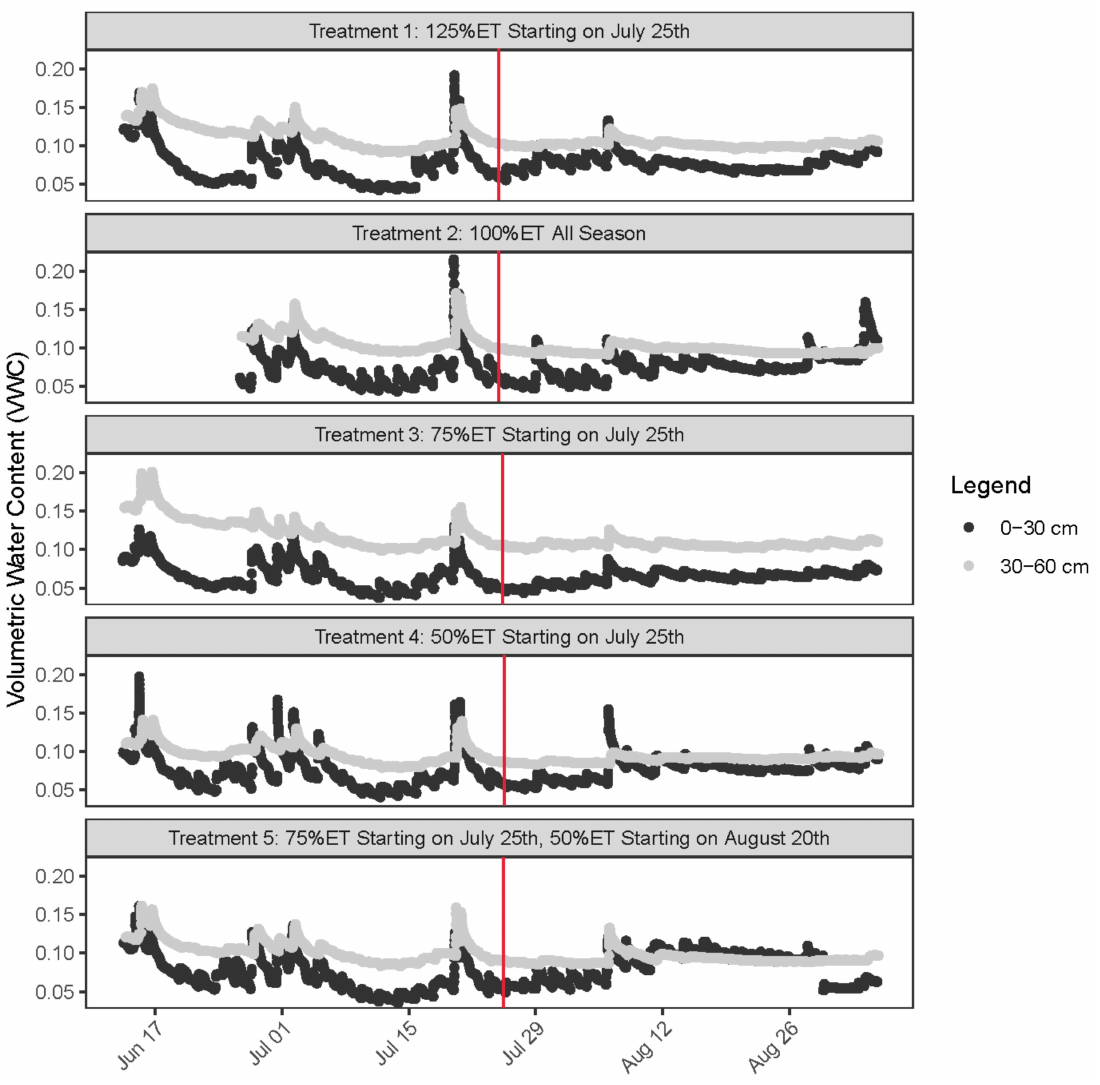
Figure 4. Volumetric water content (VWC) data from 2019. The black line indicated VWC at 0–30 cm soil depth, and the grey line indicated VWC at 30–60 soil depth. Start of the irrigation treatment, which was on 25 July, was marked by a red line. Gaps in the graphs were due to equipment